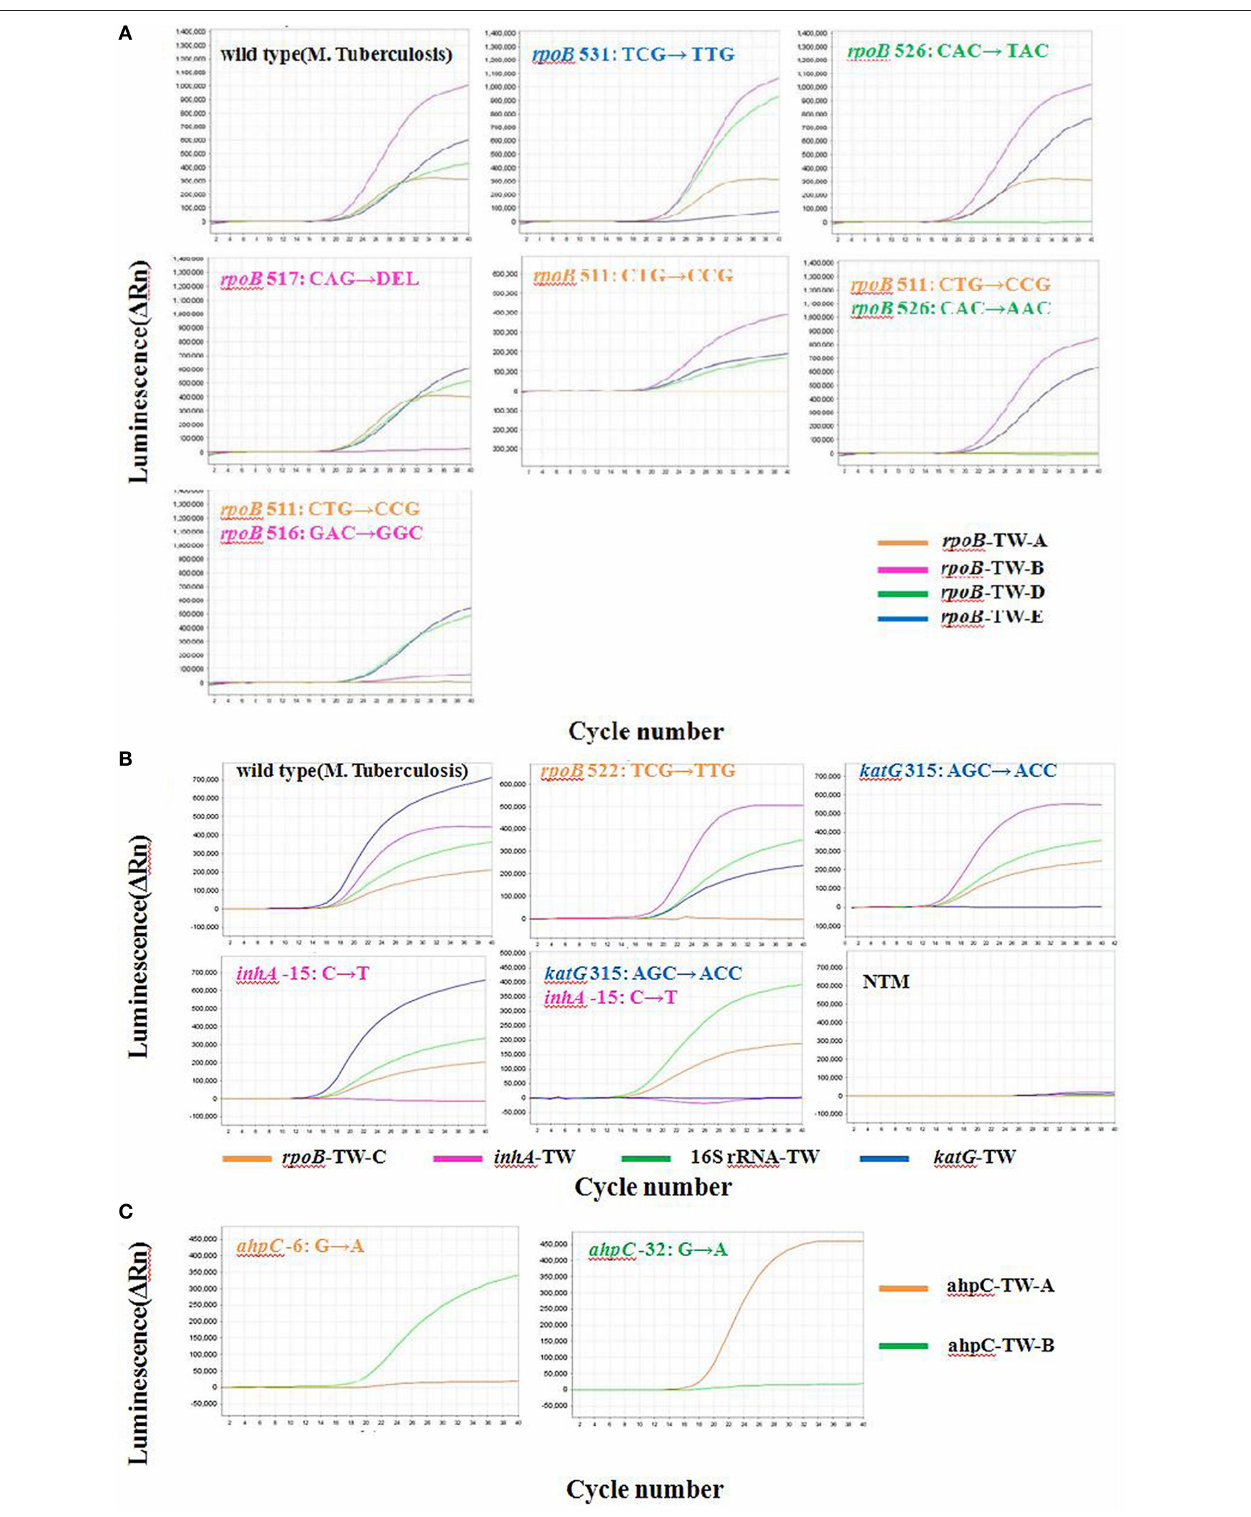
FIGURE 1 | Analysis of DNAs from Mycobacteria with 10 TaqMan probes by multi-fluorescence real-time PCR. (A) Results of reation I (B) Results of reation II (C) Results of reation III.